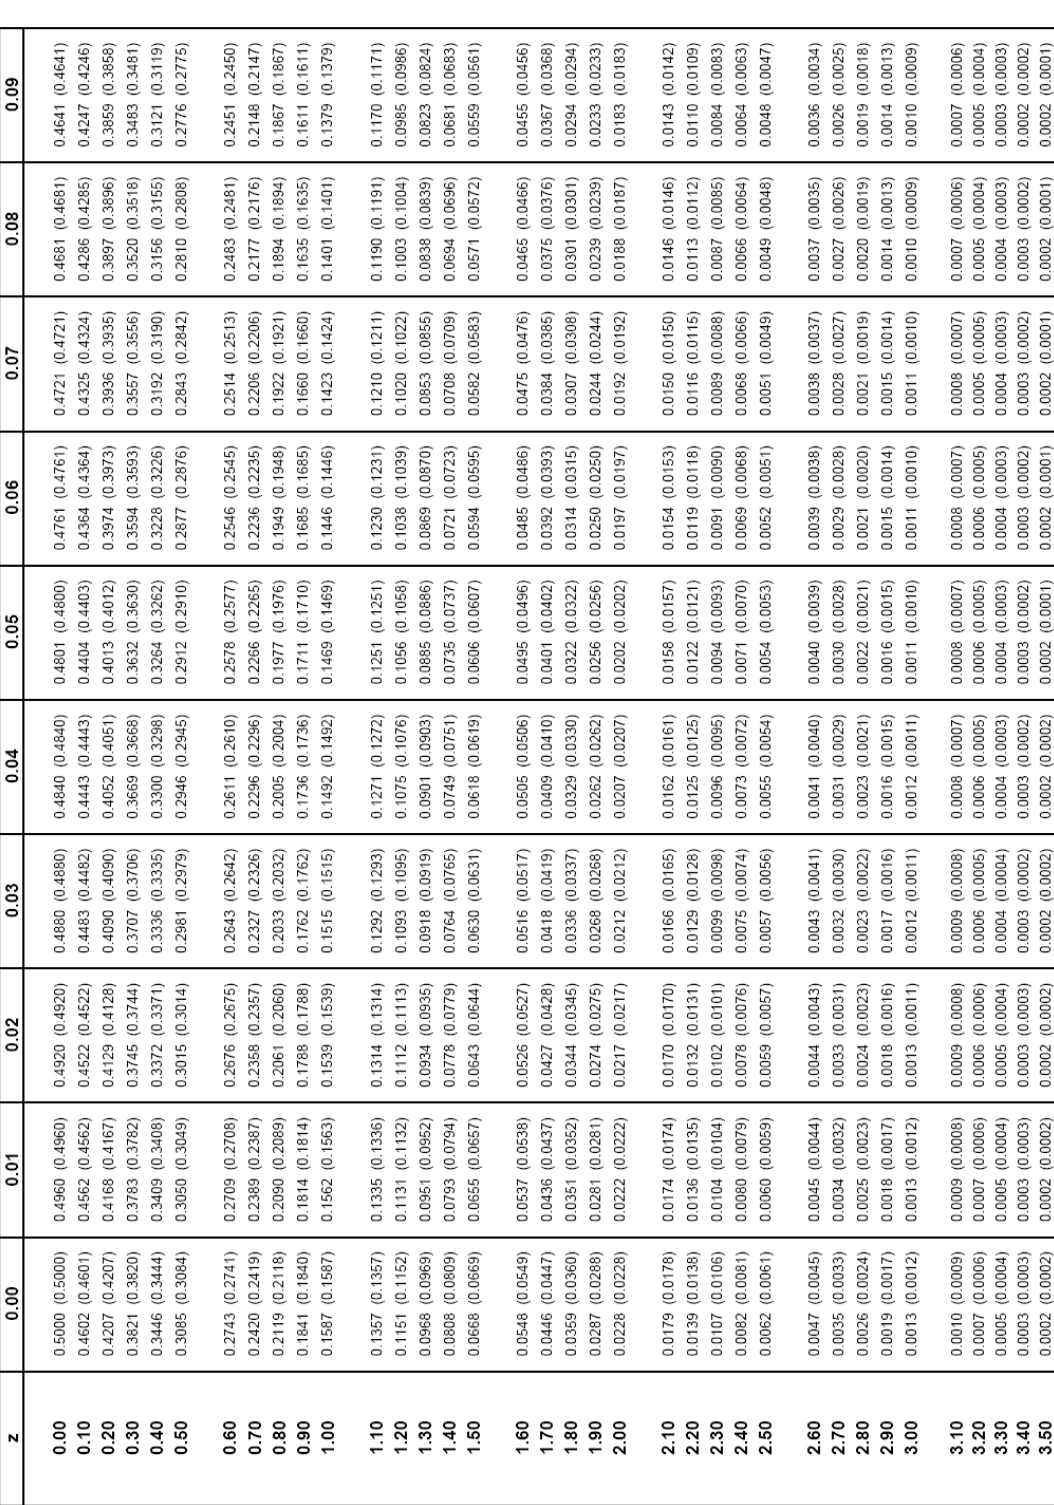
Table 3. “Standard Normal Table vs. Proposed Approximation (Approximation